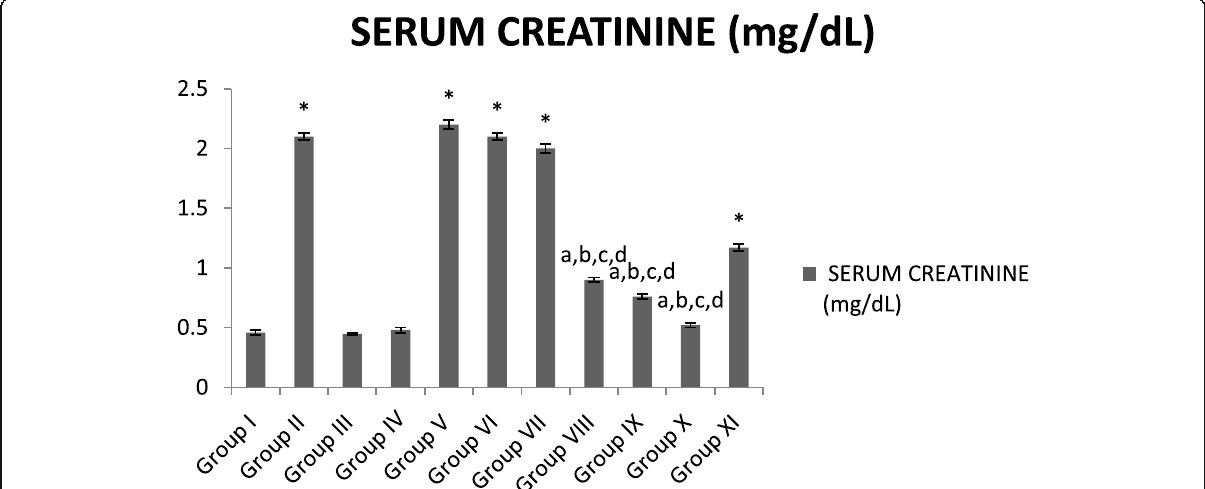
Fig. 1 Graph representing serum creatinine levels (mg/dL). All values were shown as mean ± SEM. *= p < 0.001 versus group I (normal control); a = p < 0.005 versus group II (uninephrectomised diabetic control); b = p < 0.005 versus group V (uninephrectomised diabetic rats with oleamide (1mg/kg) treatment; c = p < 0.005 versus group VI (uninephrectomised diabetic rats with oleamide (2.5mg/kg) treatment); d = p < 0.001 versus